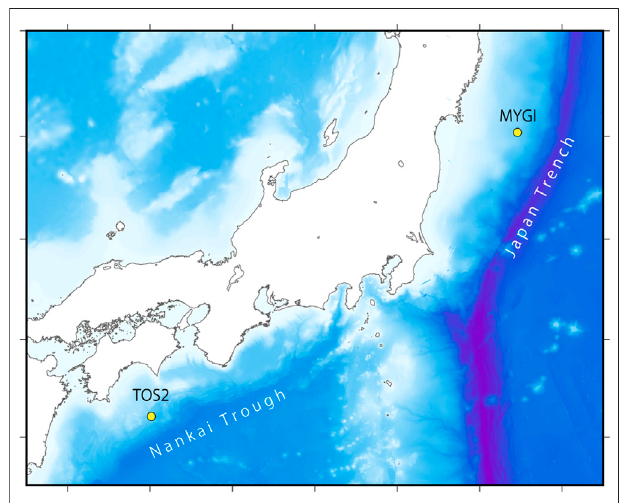
FIGURE 4 | Locations of the tested GNSS-A sites TOS2 and